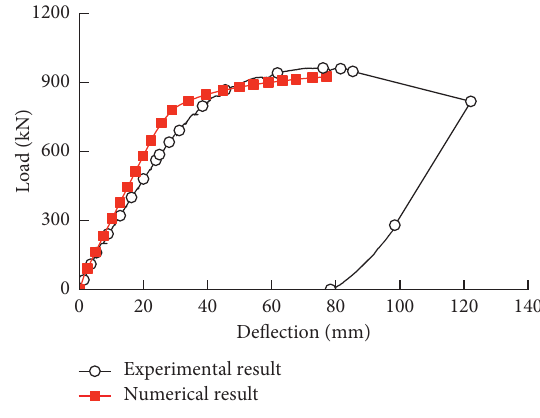
Figure 6: Load-deflection curve. Figure 7: Strand internal force vs. midspan